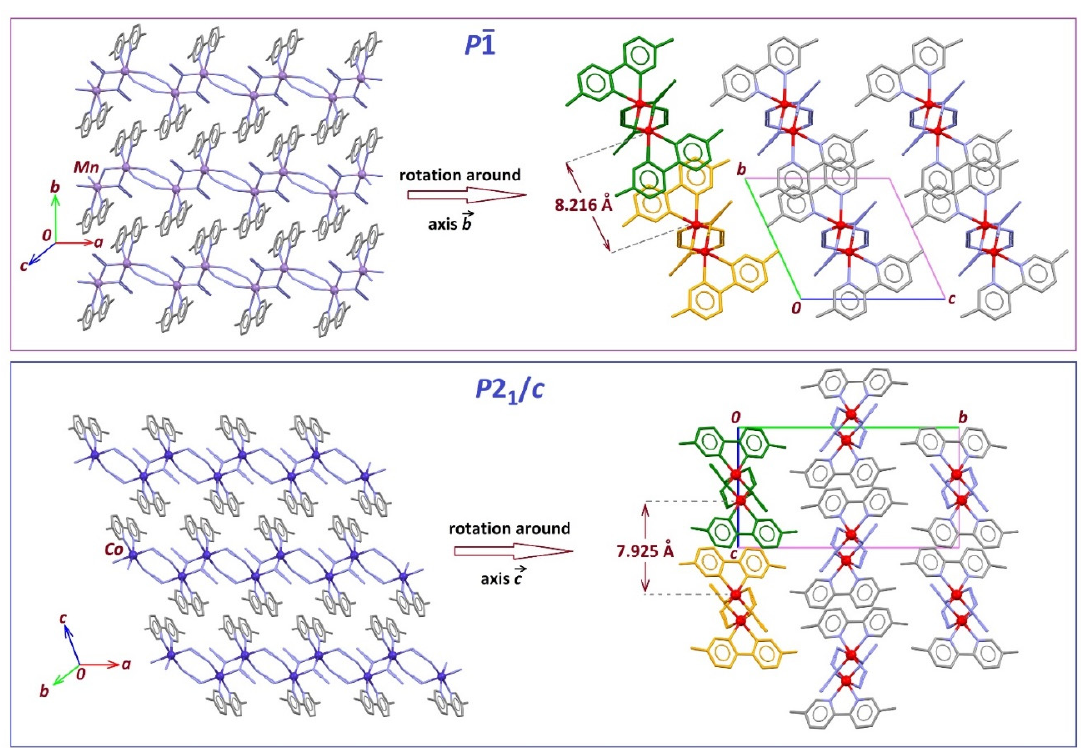
Figure 3. Projection of the packing structures for compounds 1 (top) and 2 (bottom). On the figures on the left side, crystal structures are viewed in a plane where 1D chains are parallel, emphasizing π – π interactions between aromatic rings. By rotation around a crystallographic axis, crystal structures are viewed down the polymerization direction (right side), showing the arrangement of the chains in the crystal. Green and gold parts are different parallel chains, and shortest interchain metal–metal (M–M) distances are quoted in both crystals. Closest M–M contacts are greater than 8.2 Å for 1 and greater than 7.9 Å for 2 .